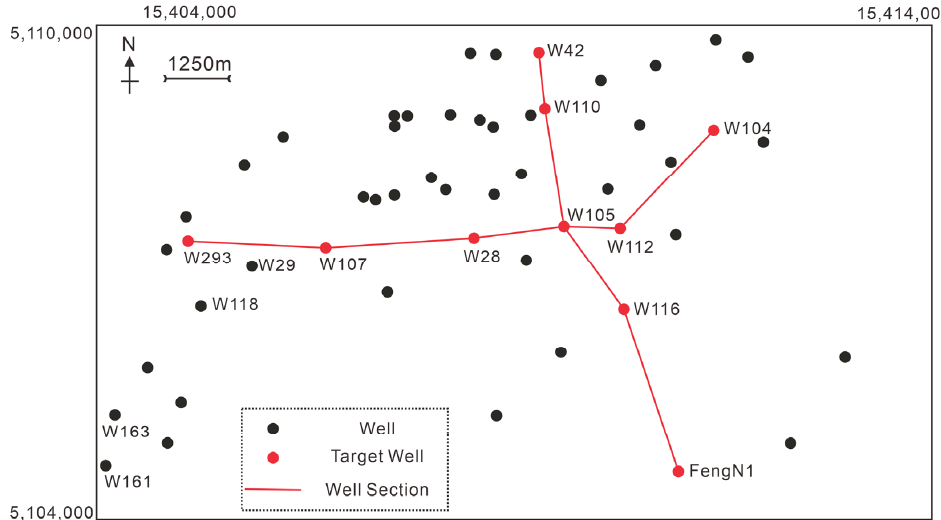
Figure 2. Location map of the W105 well area.